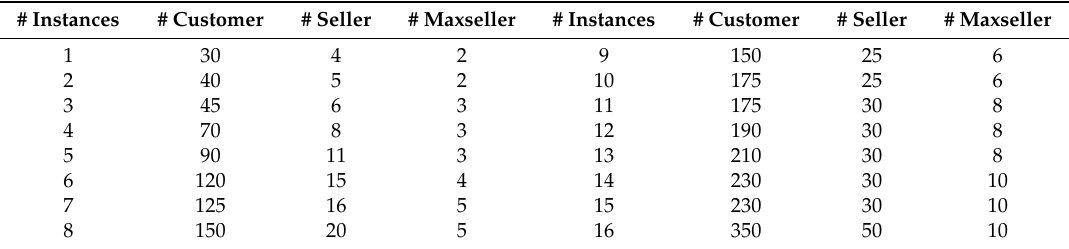
Table 12. Characteristics of the test instances and the case study.